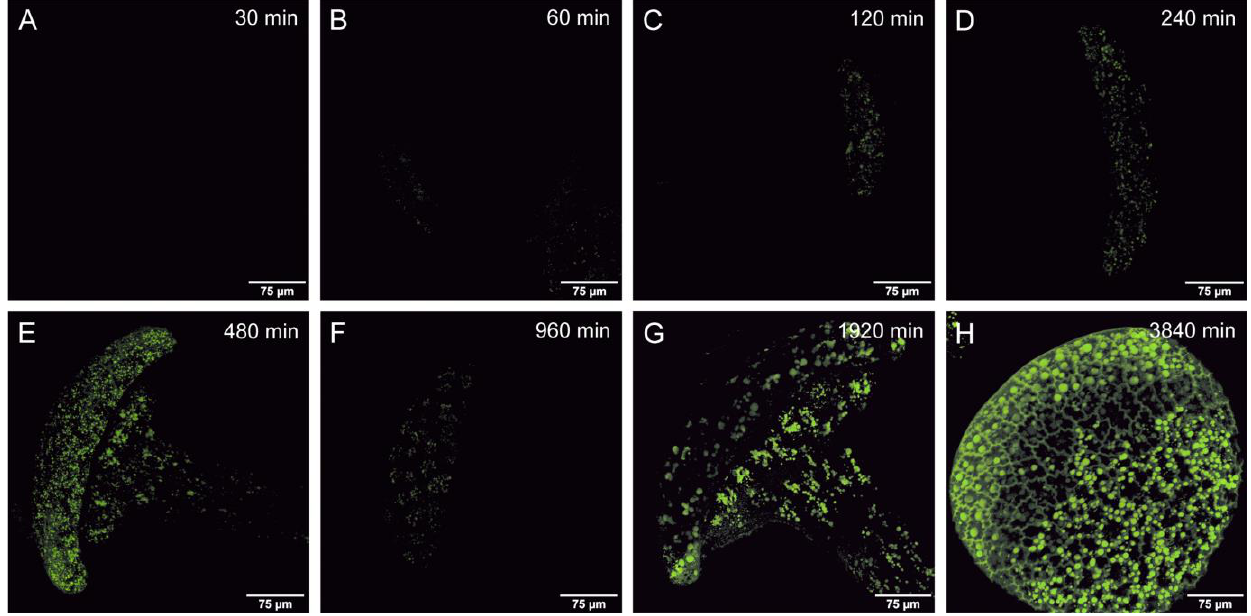
Figure 1. CLSM images of stalked glands of Drosophyllum lusitanicum ; 1% FITC BSA treated, after an incubation time of: ( A ): 30 min, ( B ): 1 h, ( C ): 2 h, ( D ): 4 h, ( E ): 8 h, ( F ): 16 h, ( G ): 32 h, ( H ): 64 h.